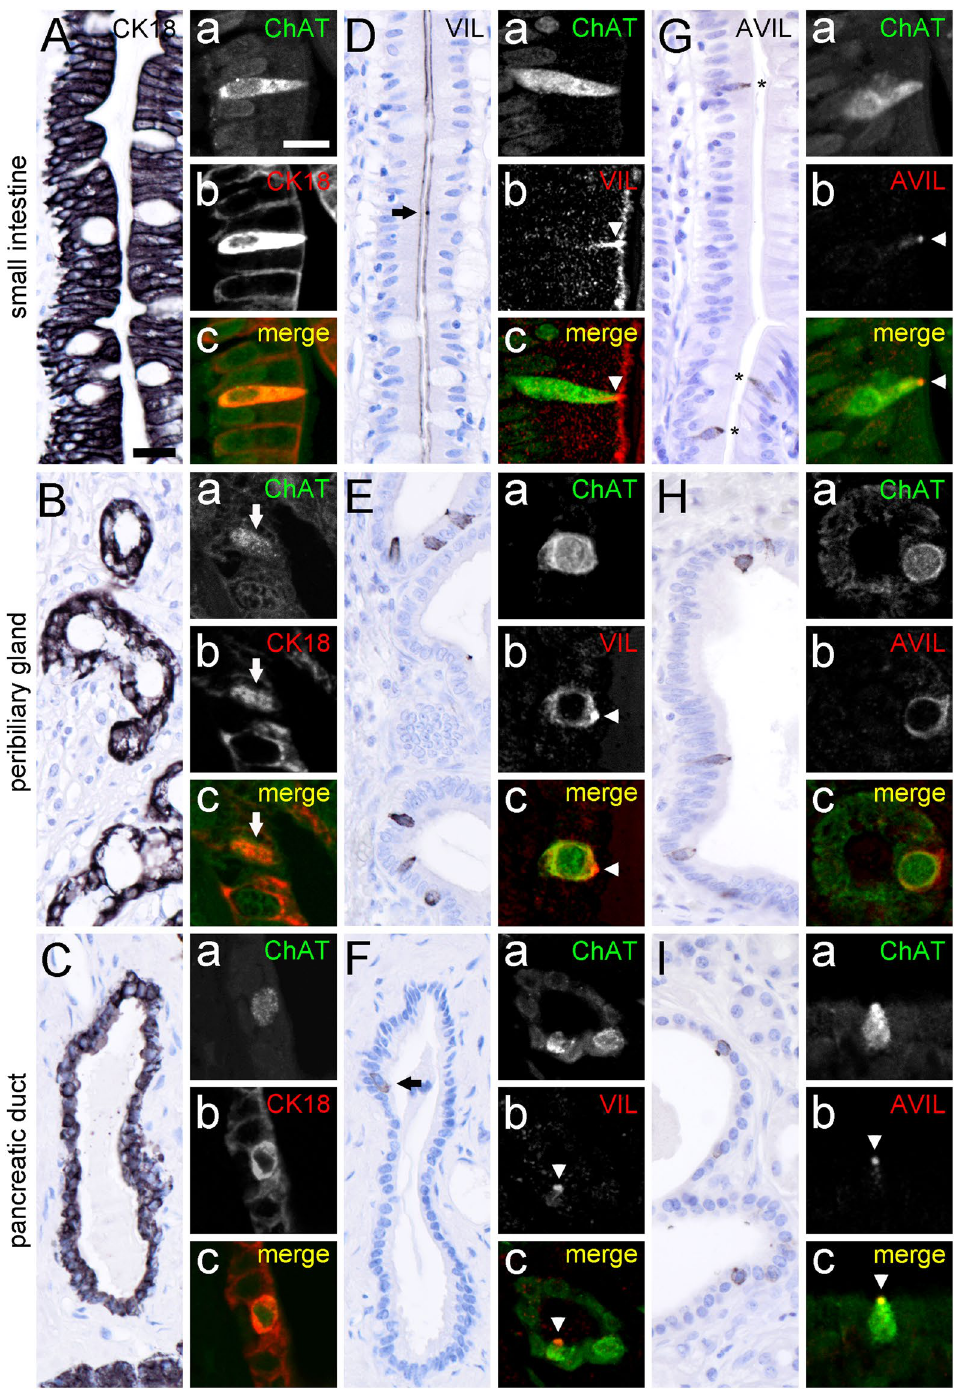
Figure 3. Presence of tuft cell morphology markers in ChAT-immunoreactive tuft cells. Cytokeratin 18 (CK18) immunoreactivity is present in many, if not all epithelial cells from the small intestine ( A ), peribiliary glands ( B ), and pancreatic ducts ( C ). Hence, double-immunofluorescence analysis of ChAT with CK18 revealed complete co-expression in human small intestine ( A a–c), peribiliary glands ( B a–c, arrow points to ChAT/ CK18 co-immunoreactive cell), and pancreatic ducts (C a–c). Villin (VIL) immunoreactivity is present at the apical brush border of almost all intestinal epithelial cells ( D ). Local accumulations indicate location of tuft cells (arrow in D ), which is confirmed by double labeling of ChAT with VIL (Da–c, arrowhead points to VIL accumulation in tuft cell brush border). VIL immunoreactivity is also present in solitary cells in extrahepatic peribiliary glands ( E ) and in pancreatic ducts ( F ). Again, ChAT immunoreactivity is present in VIL immunoreactive cells ( E a–c, and F a–c); arrowheads demarcate VIL immunoreactivity in apical tuft). Advillin (AVIL) immunoreactivity is restricted to solitary cells in the epithelial lining of the small intestine ( G , asterisks), peribiliary glands ( H ), and pancreatic ducts ( I ). In all these locations AVIL co-localized to ChAT ( G a–c, H